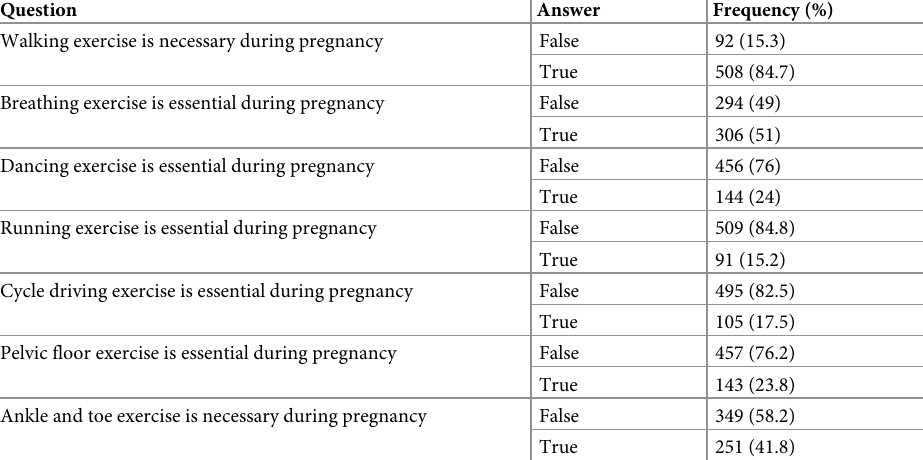
Table 4. Women’s knowledge on the benefit of antenatal physical exercise during pregnancy among pregnant women in Hawassa city, Sidama Regional State, Ethiopia, 2021.